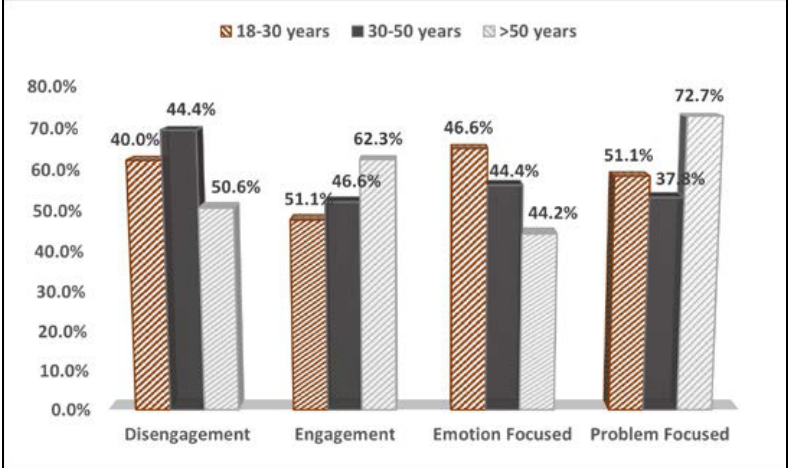
Figure 1. Comparison of COPE-60 questionnaire results by age group.